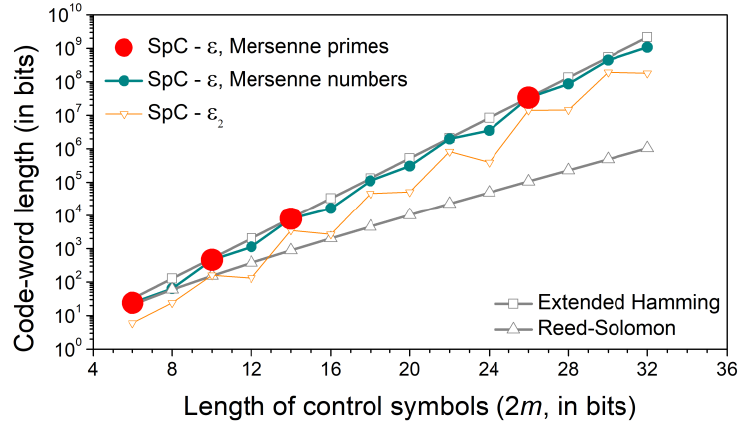
Figure 4. Comparison of code-word lengths for RS code that corrects an entire symbol, extended Hamming code that corrects a single bit, splitting code with ℰ and Mersenne prime or Mersenne number that corrects a single bit plus corresponding error patterns, splitting code with ℰ 2 that corrects a single bit, a pair of bits plus corresponding error patterns. Table 3. The cardinality of the truncated splitting sets 𝒮 T2 f or ℰ 2 .